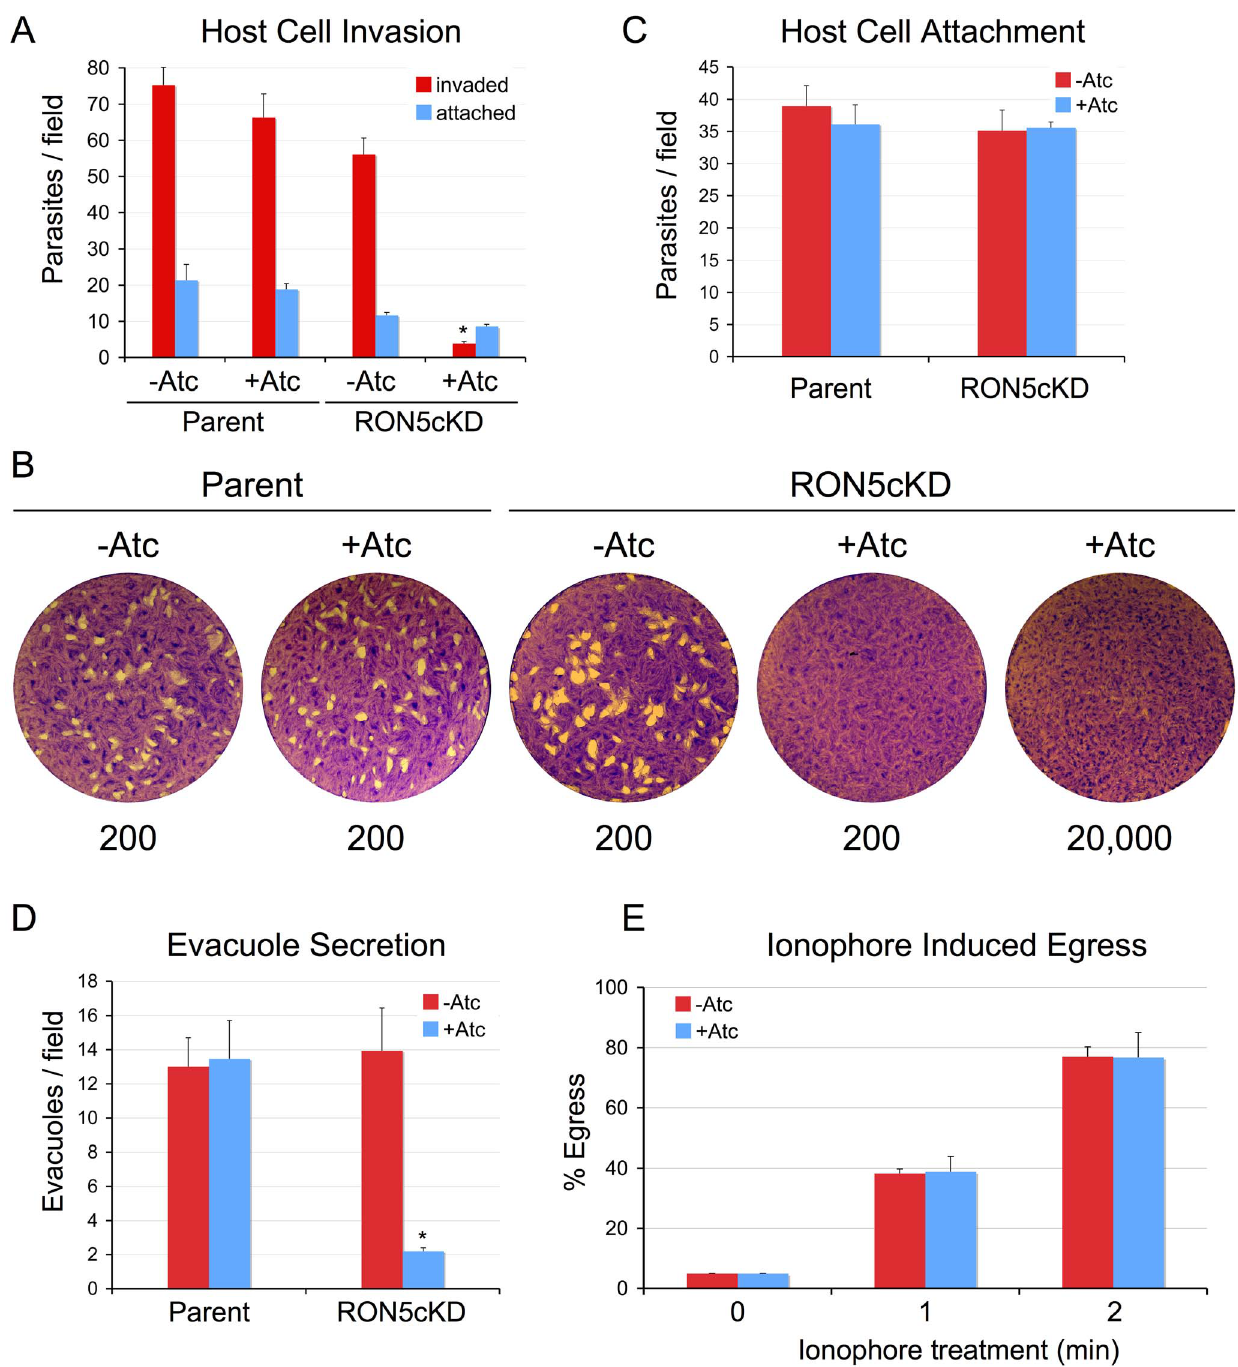
Figure 3. RON5 is critical for host invasion but not egress. (A–B) A major invasion defect is observed in parasites that lack RON5. (A) Parental or RON5 MYC cKD parasites were grown for 72 hours 2 / + Atc and then allowed to invade into fresh host cells for one hour. Following depletion of RON5, parasites show a nearly complete block in host penetration (asterisk, p-value , 0.001). A corresponding increase in attached, uninvaded parasites is not observed (blue bars). A minor decrease in penetration is also seen for untreated RON5 MYC cKD parasites, likely due to the lower levels of RON5 expressed in this strain relative to the parental line. (B) Parasites depleted of RON5 cannot form plaques in fibroblast monolayers. Parental or RON5 MYC cKD parasites were grown 48 hours 2 / + Atc and then infected into fresh fibroblast monolayers at a dose of 200 parasites per well and incubated for nine days. RON5 MYC cKD parasites are unable to form plaques in the presence of Atc, even at an infective dose of 20,000 parasites per well. Numbers under images indicate infective dose. (C) Initial attachment is not affected by knockdown of RON5. Parasites were grown for 60 hours 2 / + Atc before treatment with cytochalasin D to block motility and arrest the invasion process just after attachment. (D) Loss of RON5 eliminates secretion of rhoptry body proteins as assessed by evacuole formation (asterisk, p-value , 0.001). Parasites were grown for 60 hours 2 / + Atc before treatment with cytochalasin D to block invasion and allow evacuole formation. Evacuoles were detected by staining for ROP2/3/4. (E) Parasite egress is unaffected by loss of RON5. Parasites were grown 60 hours 2 / + Atc and then induced to egress by treatment with calcium ionophore A23187 before fixation and staining for detection with anti-SAG1. No difference was seen in egress efficiency of parasites with or without RON5. doi:10.1371/journal.ppat.1004025.g003 PLOS Pathogens |